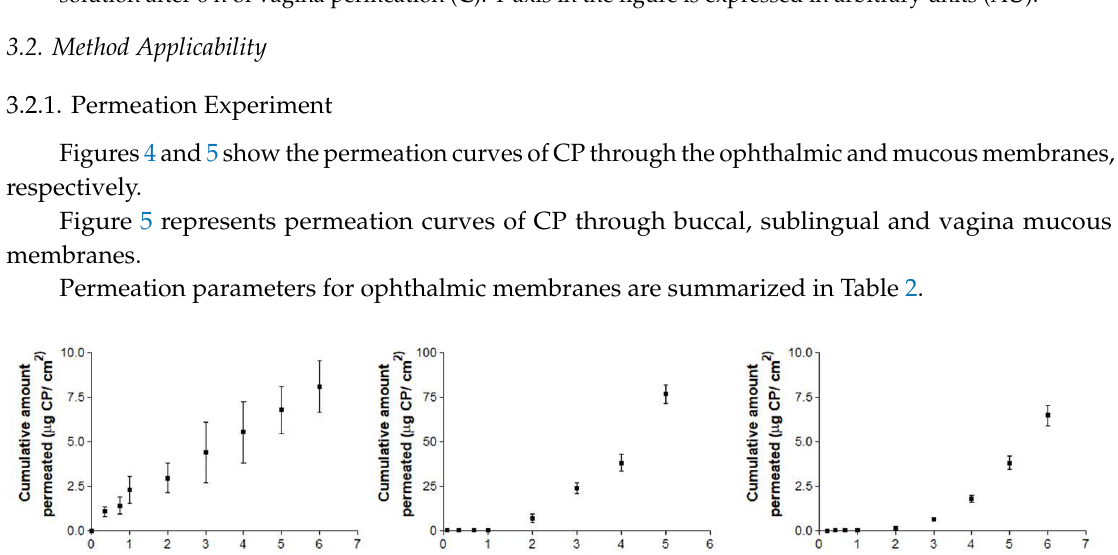
Figure 5. Ex vivo conjunctiva buccal (left), sublingual (center) and vagina permeation (right) profiles of CP over 6 h, expressed by mean ± SD of six replicates (n = 6). Permeation parameters for ophthalmic membranes are summarized in Table 2. Table 2. Median, maximum and minimum values of flux (Js), lag time (Tl) and permeability coefficient (Kp) of CP at 6 h from CP saturated solution (CP-Sat) through ophthalmic tissues (conjunctiva, cornea and sclera). Carprofen